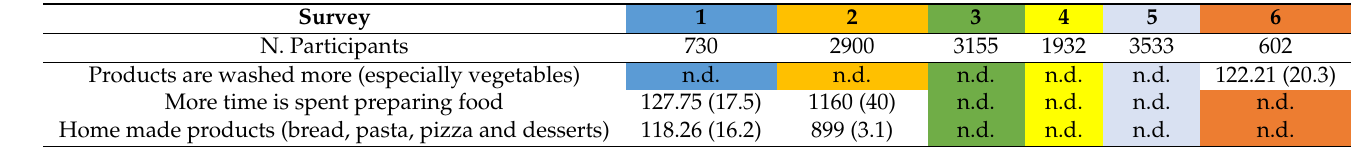
Table 6. Time spent preparing food, absolute value (N.) and (%) on the total. Survey